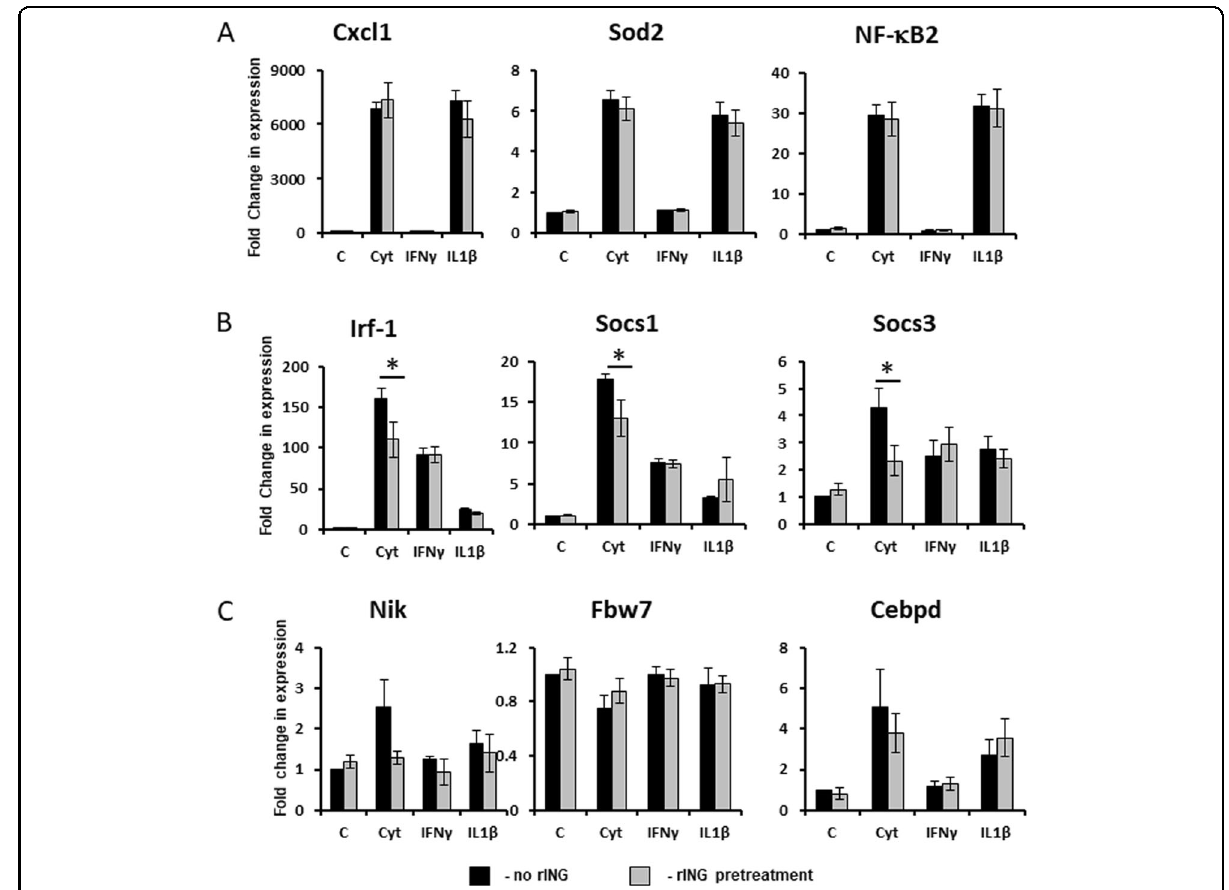
Fig. 8 Effect of rINGAP on the expression of cytokine-stimulated genes. Rinm5F cells were pre-treated with 1 nM rINGAP for 2 h and treated with cytokines, individually or in combination for 3 h and processed for RNA extraction and qRT-PCR. Experiments were repeated fi ve times. Fold change in gene expression over control (PBS) was calculated with the CFX Manager Software 3.1 using three reference genes (Gapdh, β -actin, and α - tubulin). Target stability was within the range M < 0.5, CV < 0.25. * P < 0.05 vs PBS control: t test one-tailed, two-sample equal